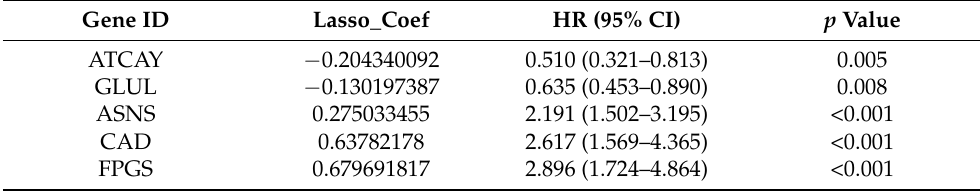
Figure 2. Screening DEGRGs related to prognosis of prostate cancer. ( A ) Univariate Cox regression analysis of glutamine-associated genes. ( B , C ) Screening glutamine-associated genes with patients’ prognosis by lasso regression analysis. ( C ) represents the variables with non-zero coefficients. From top to bottom, the first line (yellow) represents FPGS, the second line (pale purple) represents CAD, the third line (pale gray) represents ASNS, the fourth line (pale blue) represents PFAS, the fifth line (pale yellow) represents NIT2, the sixth line (pale green) represents PYCR3, the seventh line (pale red) represents GLUL, and the eighth line (blue) represents ATCAY. To ensure the accuracy of the model, lambda.min (0.0120) was chosen as λ to construct the model and screen out five genes, including ATCAY, GLUL, CAD, ASNS, and FPGS. ( D , E ) Independence analysis between the five genes. ( F ) The distribution of the five-gene risk score, the five-gene expression differences in high and low risk groups, and survival status for each patient. ( G ) Kaplan–Meier curve of BCRFS in high-risk and low-risk group. ( H ) The 1-year, 3-year and 5-year time-dependent ROC curves of the glutamine-related signature for prediction of BCRFS of patients with PCa. Table 2. The detailed information of five glutamine-related genes for the prediction